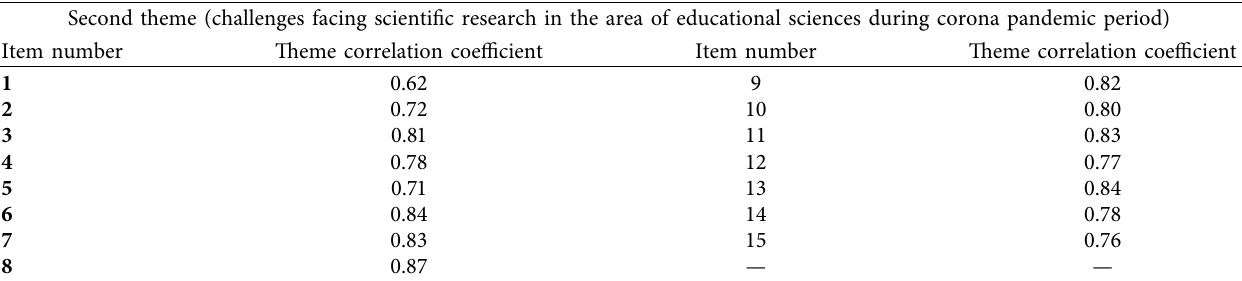
Table 4: Pearson correlation coefficients for the items of second theme with total degree of the